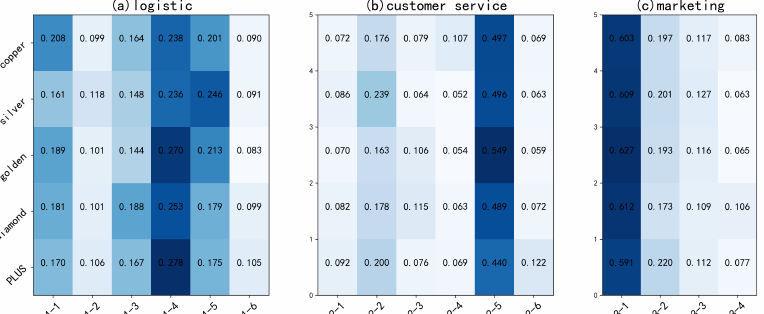
Figure 6. Proportions of detailed aspects of negative reviews for the three main reasons. In each plot, the x -axis represents different aspects, as illustrated in Table 2, and the y -axis stands for different user levels. The horizontal sum of the patches in every subplot is 1.